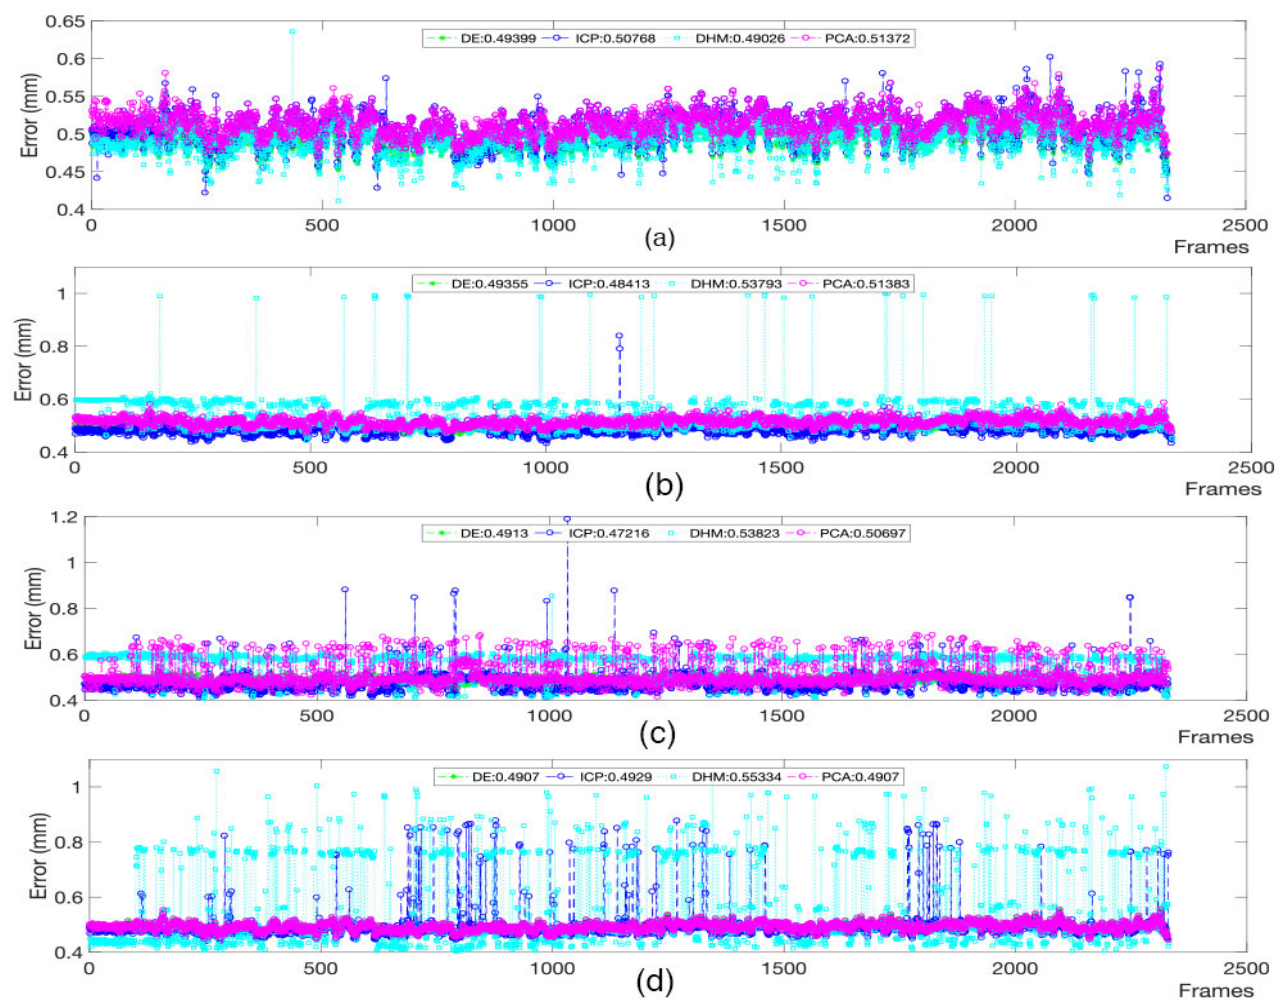
Fig. 13. Graphs showing the calculation of the error among the tested algorithms. (a) 25 percent (21 blendshapes); (b) 50 percent (41 blendshapes); (c) 75 percent (62 blendshapes) and (d) 100 percent (80 blendshapes).